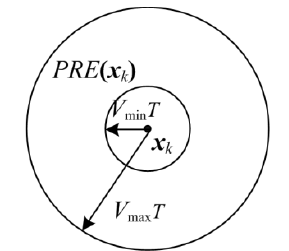
Figure 2. State transition